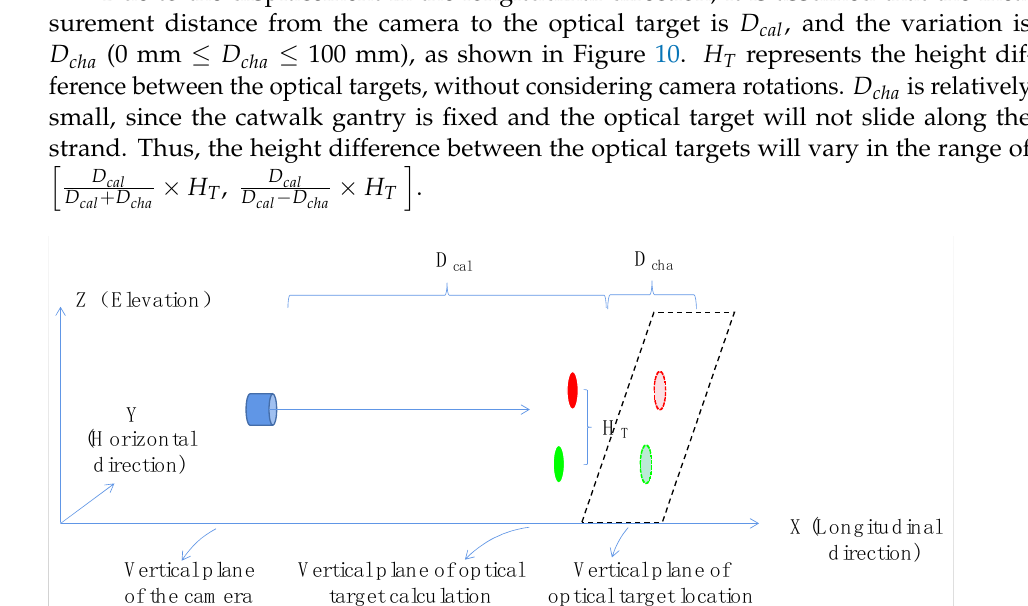
Figure 9. Schematic diagram of the camera motion.